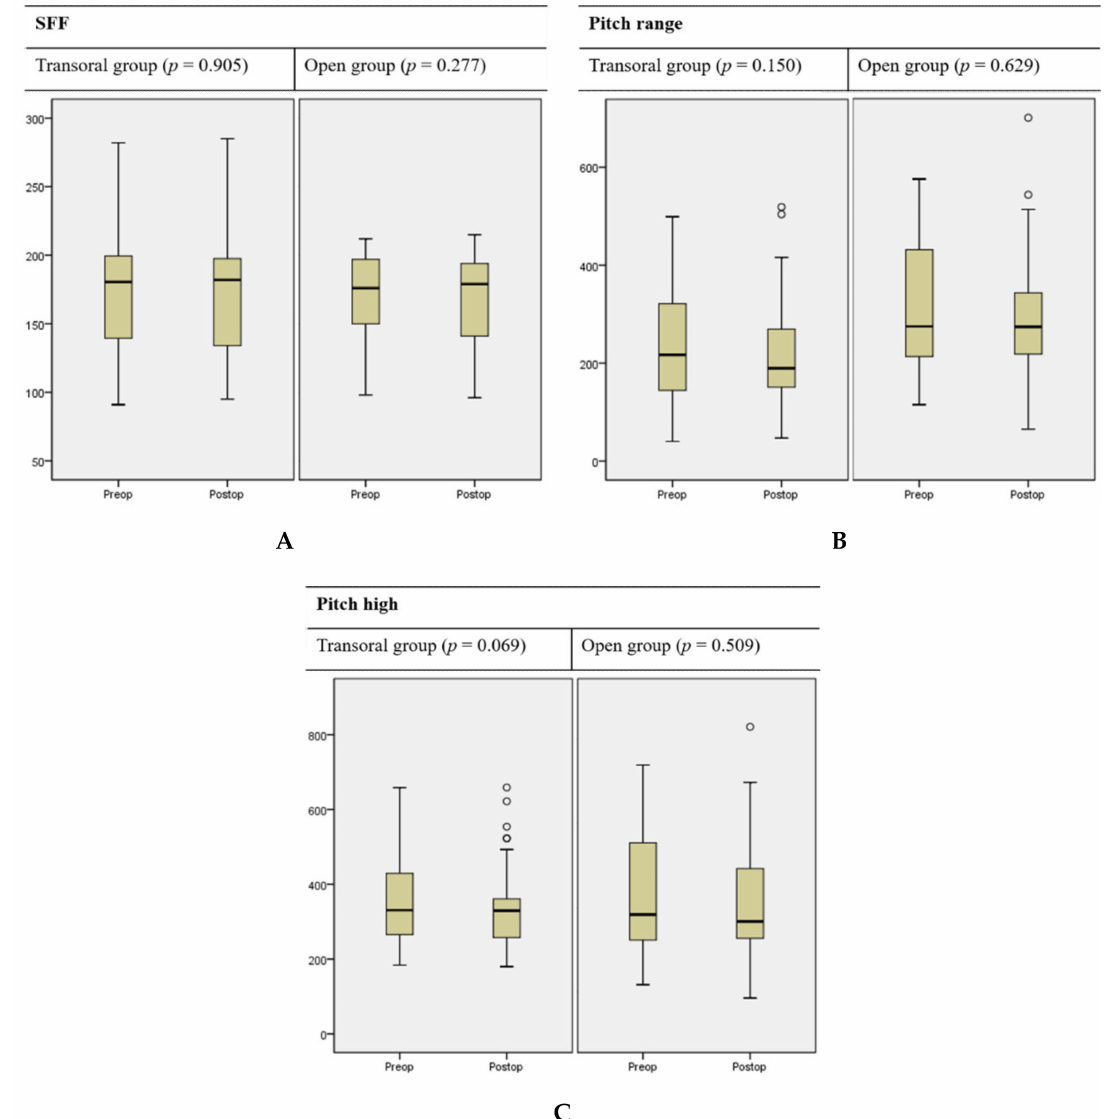
Figure 1. Postoperative changes in ( A ) the speech fundamental frequency (SFF), ( B ) the pitch range, and ( C ) high pitch in patients who underwent transoral endoscopic thyroidectomy vestibular approach (transoral group) or open thyroidectomy (open group). Circles denote strong